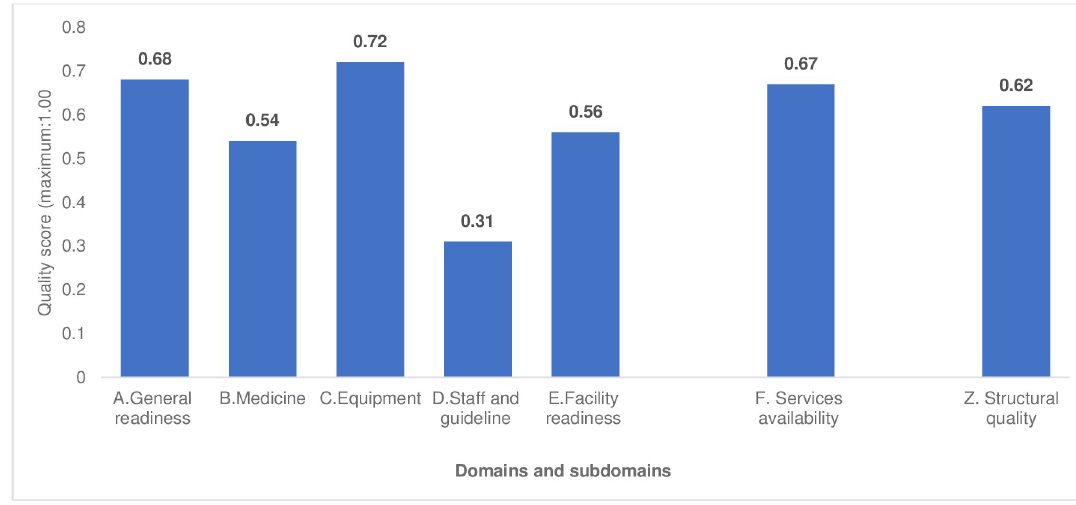
Fig 1. Structural quality score of health facilities for the ANC visit.